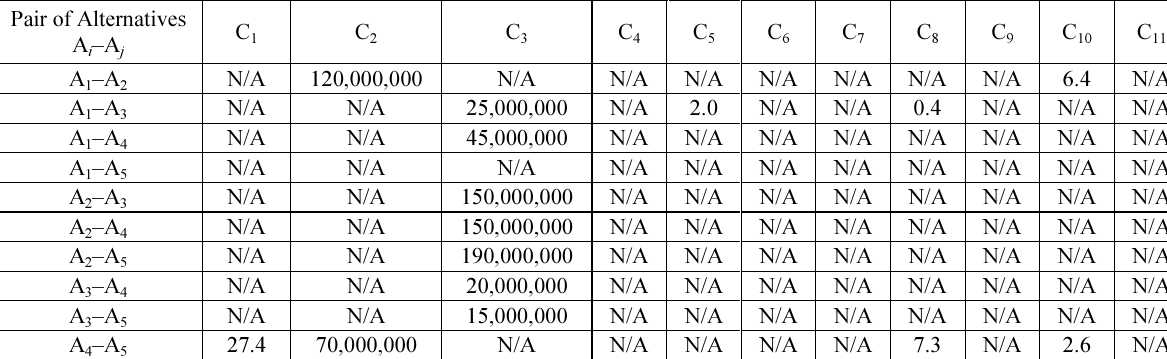
Table 14. All possible relative critical measures of performance Pair of